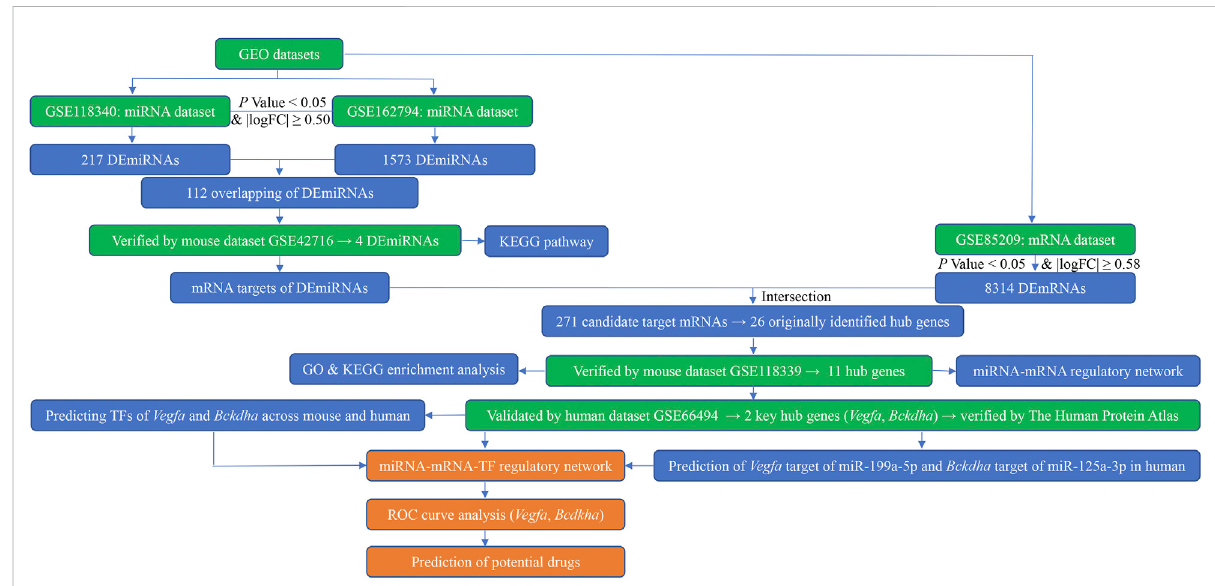
FIGURE 1 Flow diagram of bioinformatics analysis. GEO, Gene Expression Omnibus; miRNA, microRNA; mRNA, messenger RNA; logFC, log fold change; DEmiRNAs, differentially expressed miRNAs; DEmRNAs, differentially expressed mRNAs; KEGG, Kyoto Encyclopedia of Genes and Genomes; GO, Gene Ontology; TFs, transcription factors; ROC, receiver operating